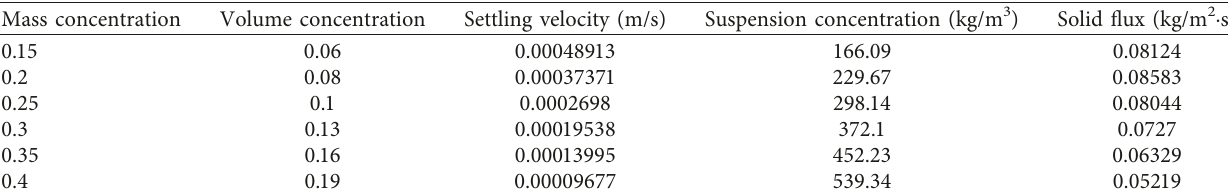
Table 3: Results of tailing settling experiment.